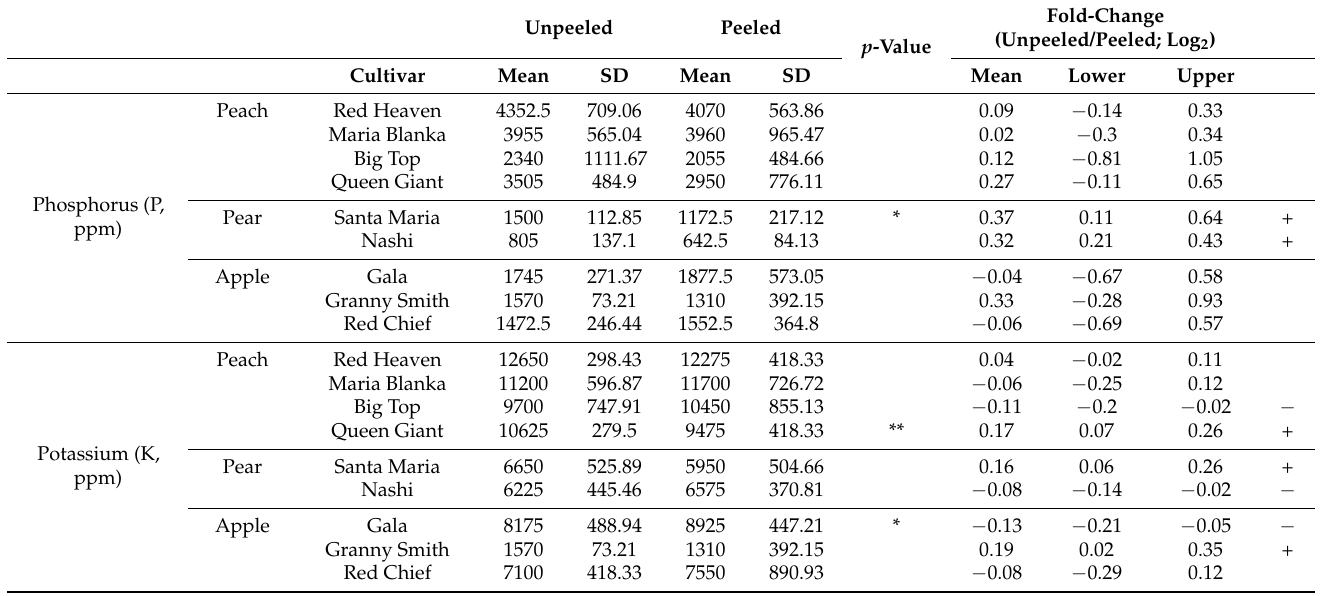
Table 2. Nutrient elements composition of unpeeled and peeled fruit at four peach cultivars (Red Heaven, Maria Blanka, Big Top, Queen Giant), two pear cultivars (Santa Maria, Nashi), and three apple cultivars (Gala, Granny Smith, Red Chief) after cold